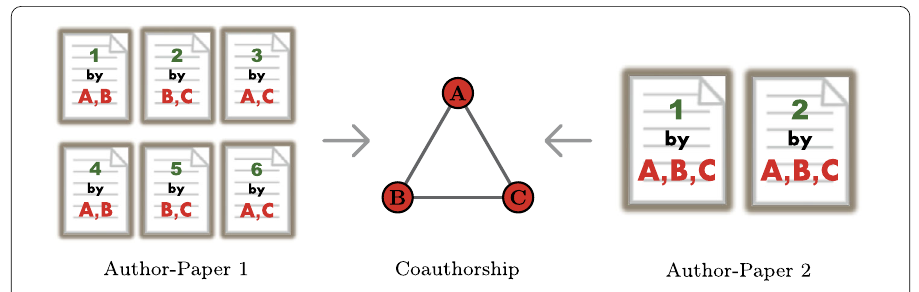
Figure 1 Two author-paper networks and their coauthorship graph. Letters denote authors and numbers denote paper titles. These networks may be structured as hypergraphs on vertices A , B , C with hyperedges e 1 = e 2 = { A , B , C } for the rightmost network, and hyperedges e 1 = e 4 = { A , B } , e 2 = e 5 = { B , C } , e 3 = e 6 = { A , C } for the